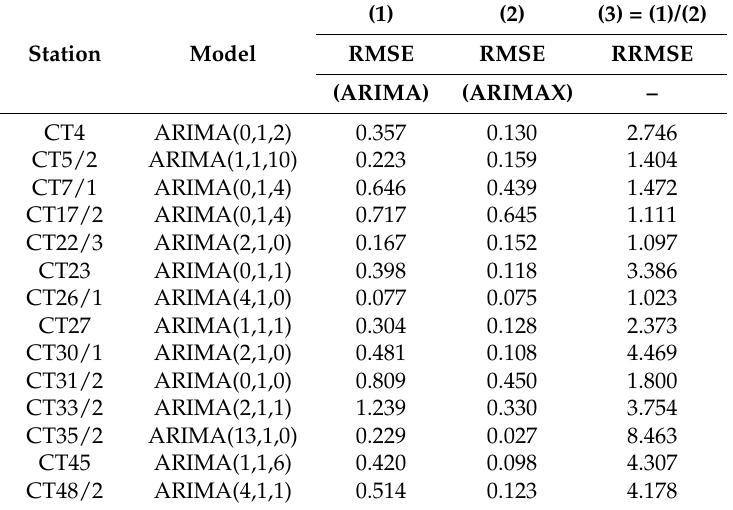
Table 10. Comparison of accuracy of ARIMA model and ARIMAX model forecasting. Station